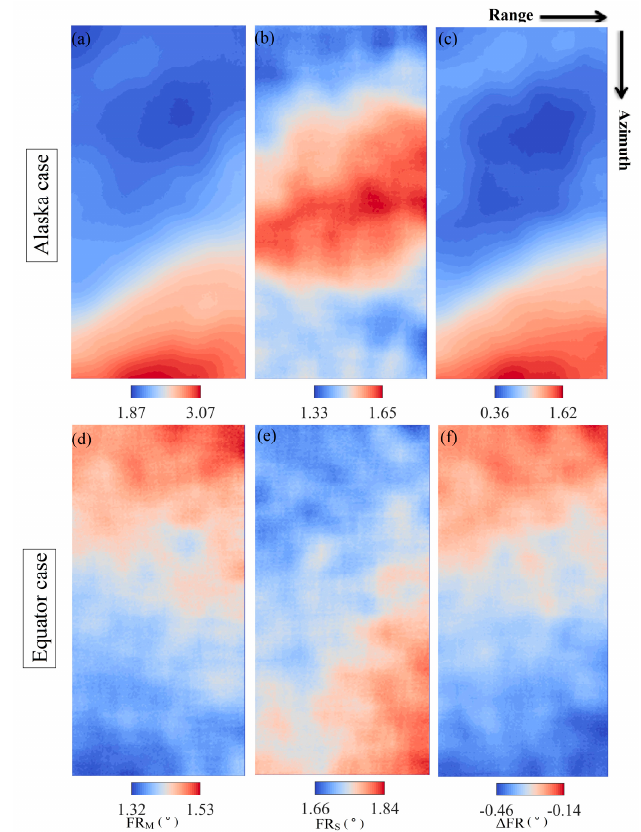
Figure 4. ( a – c ) Estimated Faraday rotation (FR) for the master and slave, and di ff erential FR in the Figure 4. ( a ‒ c ) Estimated Faraday rotation (FR) for the master and slave, and differential FR in the Alaska case. ( d – f ) Estimated FR and di ff erential FR in the Equator Alaska case. ( d ‒ f ) Estimated FR and differential FR in the Equator case.